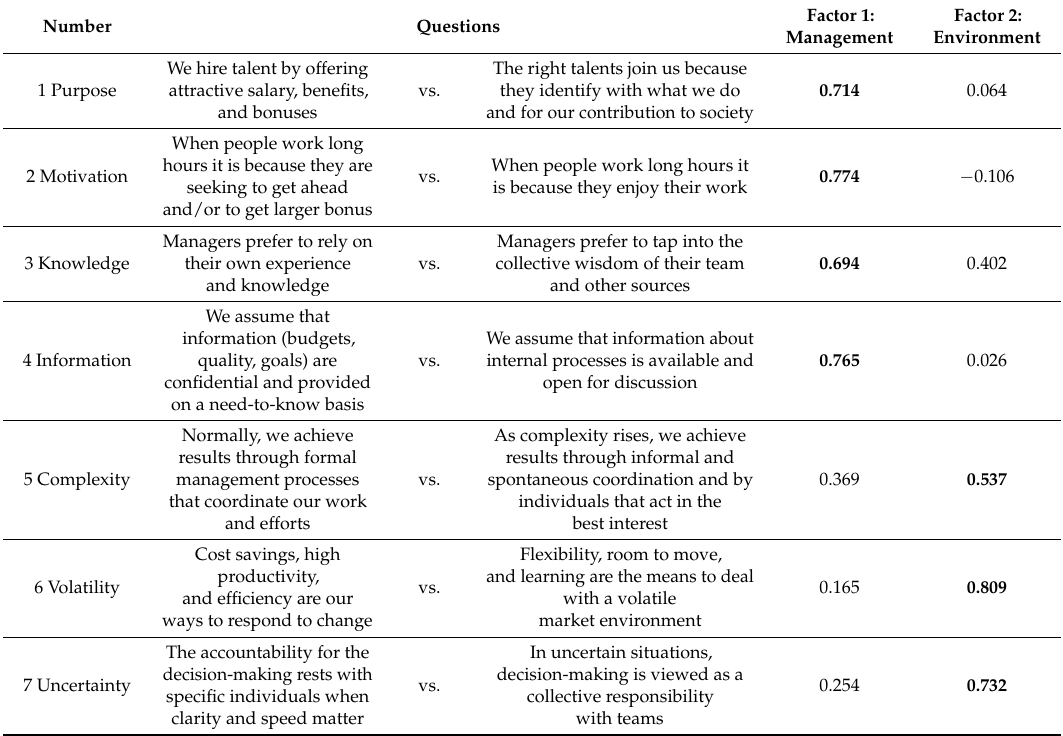
Table 4. Exploratory factor analysis